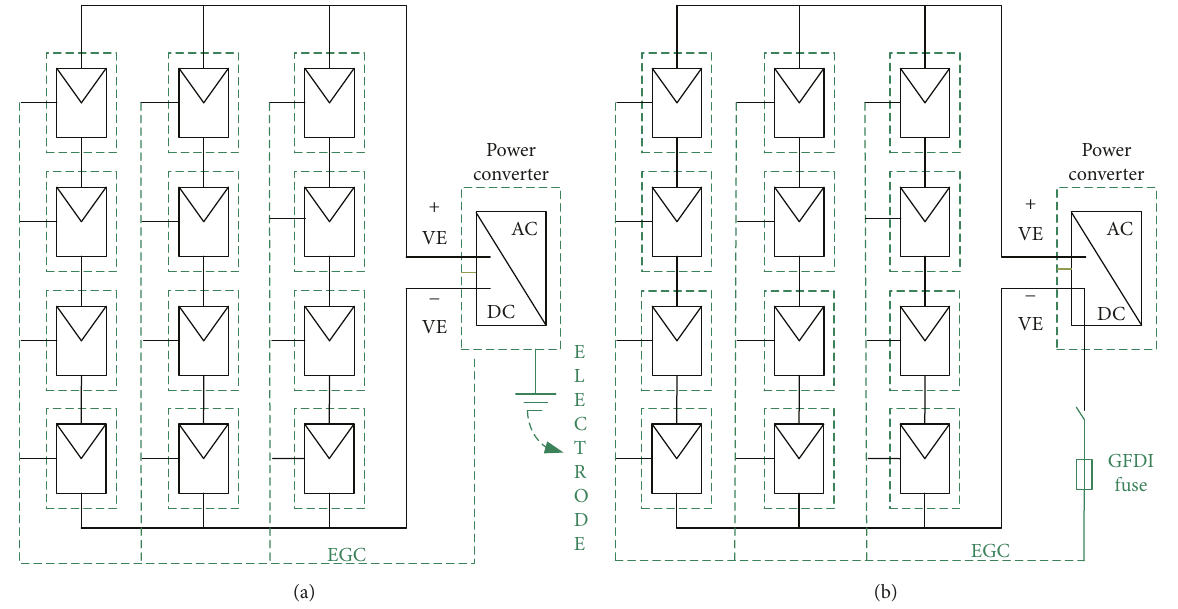
Figure 8: Schematic diagram of (a) grounded and (b) ungrounded PV systems.